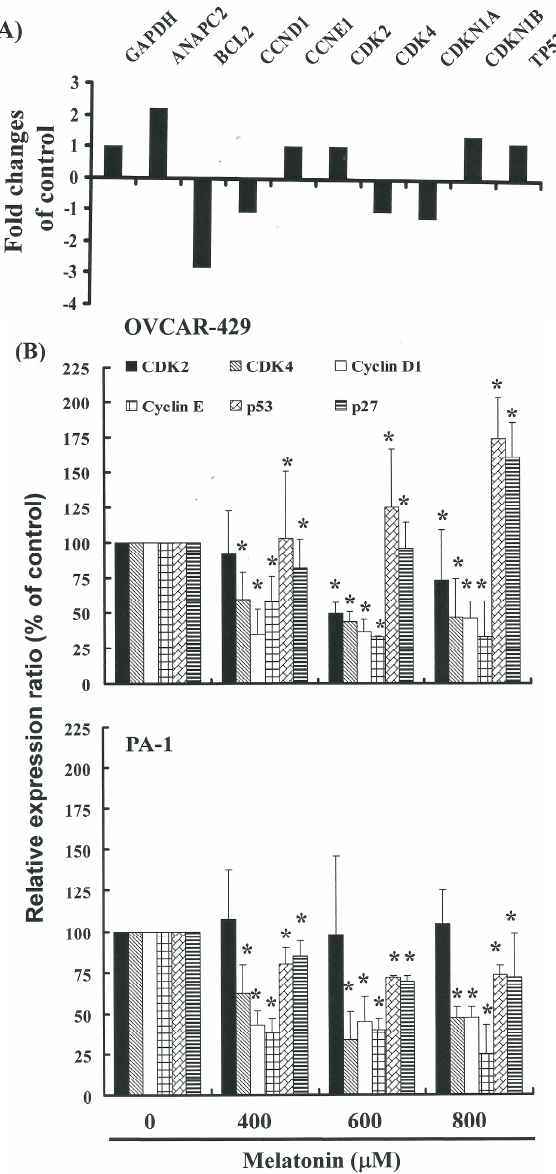
Figure 4. ( A ) The focused panel gene expression profile of OVCAR-429 cells was studied using the RT 2 Profilter TM PCR array following 4 h-exposure to vehicle (DMSO) or melatonin. Fold changes greater than 2 (up-regulation) or smaller than 0.5 (down-regulation) were considered substantial. Fold changes were calculated by dividing expression levels in melatonin-treated groups by expression levels in the vehicle-treated cells. ANAPC2: Anaphase promoting complex subunit 2, BCL2: B-cell CLL/lymphoma 2, CCND1: Cyclin D1, CCNE1: Cyclin E1, CDK2; Cyclin-dependent kinase 2, CDK4: Cyclin-dependent kinase 4, CDKN1A: Cyclin-dependent kinase inhibitor 1A (p21, Cip1), CDKN1B: Cyclin-dependent kinase inhibitor 1B (p27, Kip1), TP53: Tumor protein p53; ( B ) Melatonin induced a gene expression in OVCAR-429 and PA-1 cell lines. Quantitative RT-PCR (qPCR) analysis of CDK 2, 4, p27, and p53 mRNA expression standardized against the levels of GAPDH in ovarian cancer cell lines exposed for 4 h to DMSO (melatonin 0 µM control) or melatonin. Results were expressed as a percentage of control, which was considered 100%. All data were reported as the mean (±SEM) of at least three separate experiments. Symbol (*) in each group of bars indicates that the difference resulting from treatment with melatonin 0 µM is statistically significant at p < 0.05.